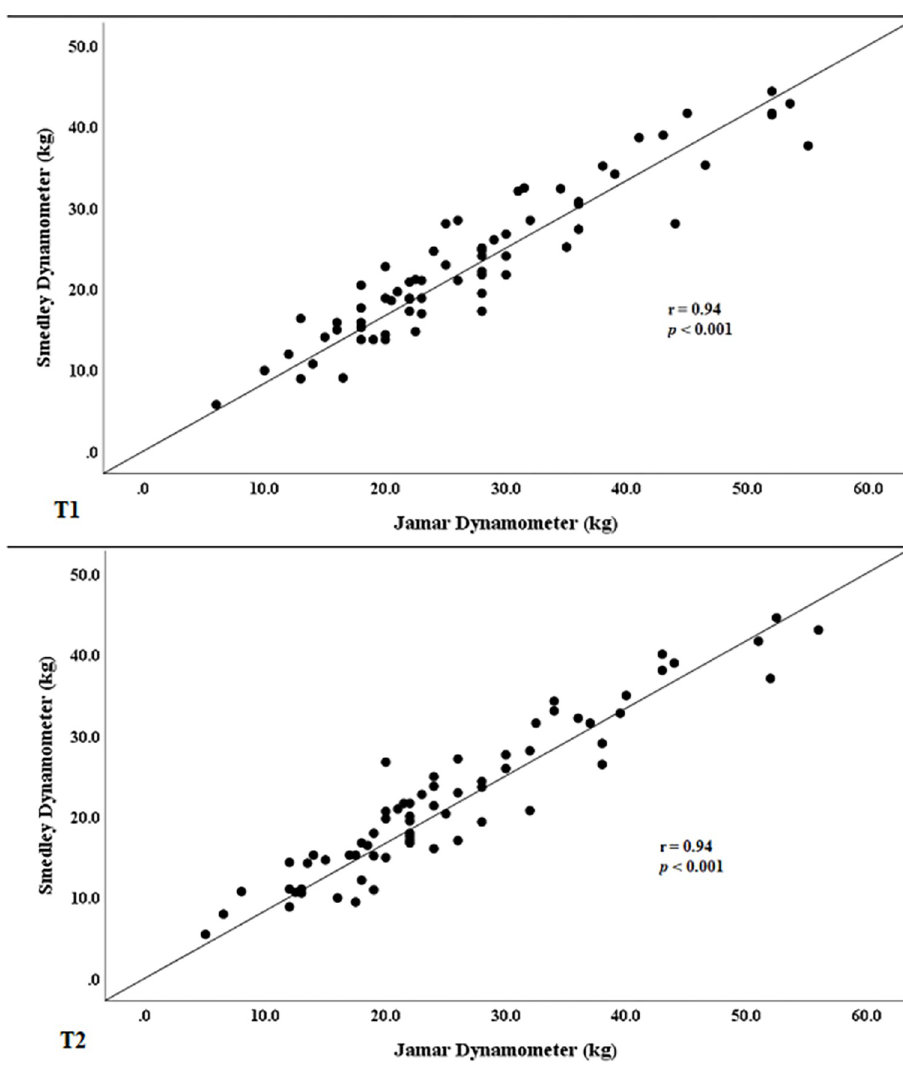
Fig 1. Correlation between devices at T1 (top) and T2 (bottom). Hand grip measurements were strongly and positively correlated at both